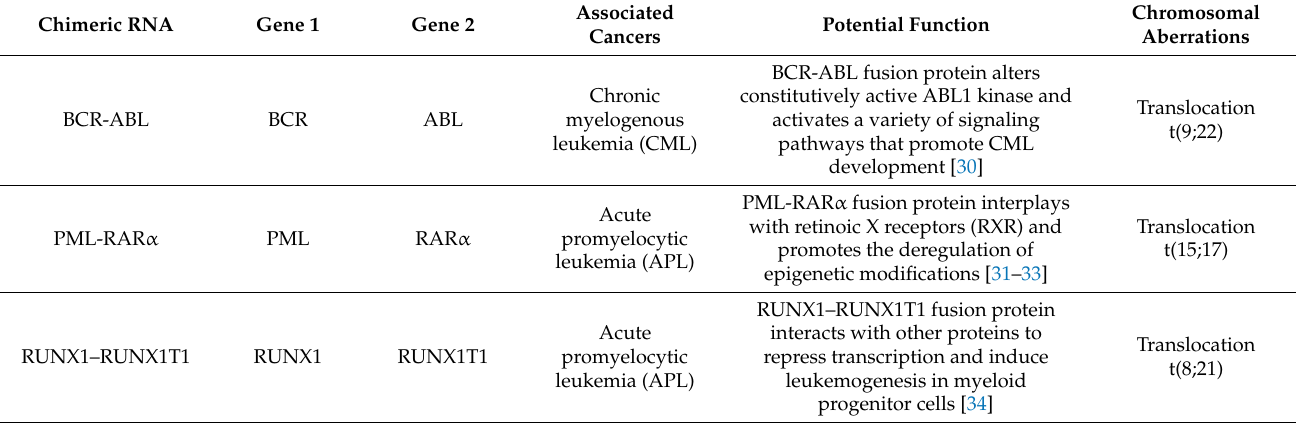
Table 1. Chimeric RNAs generated due to chromosomal aberrations in different cancers and their potential functions. Chimeric